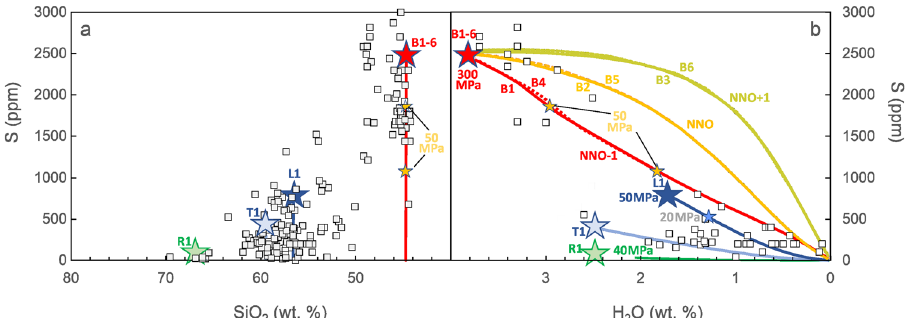
Fig. 7 Melt inclusion data compared to degassing models. a SiO 2 vs. S scatter plot for the melt inclusion Vulcano island populations (data from Supplementary Table 3). We observe a drop in MI S contents from basaltic to intermediate (latitic) and silicic (trachytic to rhyolitic) melt compositions. The large stars labelled B1 – B6, L1, T1 and R1 indicate the initial compositions of the degassing model runs (Supplementary Table 4). The solid red lines indicate the range of S contents predicted in the basaltic model runs (B1 – B6) upon decompression degassing in the 300 – 0.1 MPa pressure range. Small stars indicate the model-predicted dissolved S content in basaltic melts at 50 MPa at the B1 (upper star) and B6 (bottom star) run conditions. b H 2 O vs. S scatter plot for the melt inclusion Vulcano island populations (data from Supplementary Table 3). The solid lines indicate the model-predicted dissolved H 2 O and S contents in the melt along the modelled degassing paths. Stars as in ( a ) with the addition of a small blue star indicating the modelled dissolved S content in the L1 model latitic melt at 20